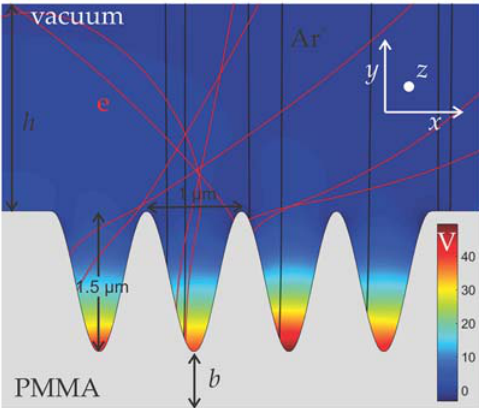
Figure 4. The initial sinusoidal profile of the PMMA surface. The steady state potential, as well as some of the ion (in black) and electron (in red) trajectories, are also depicted. h is the height of the vacuum space, and b is the thickness of the PMMA layer. h is 2.2 μ m, and b >> h .